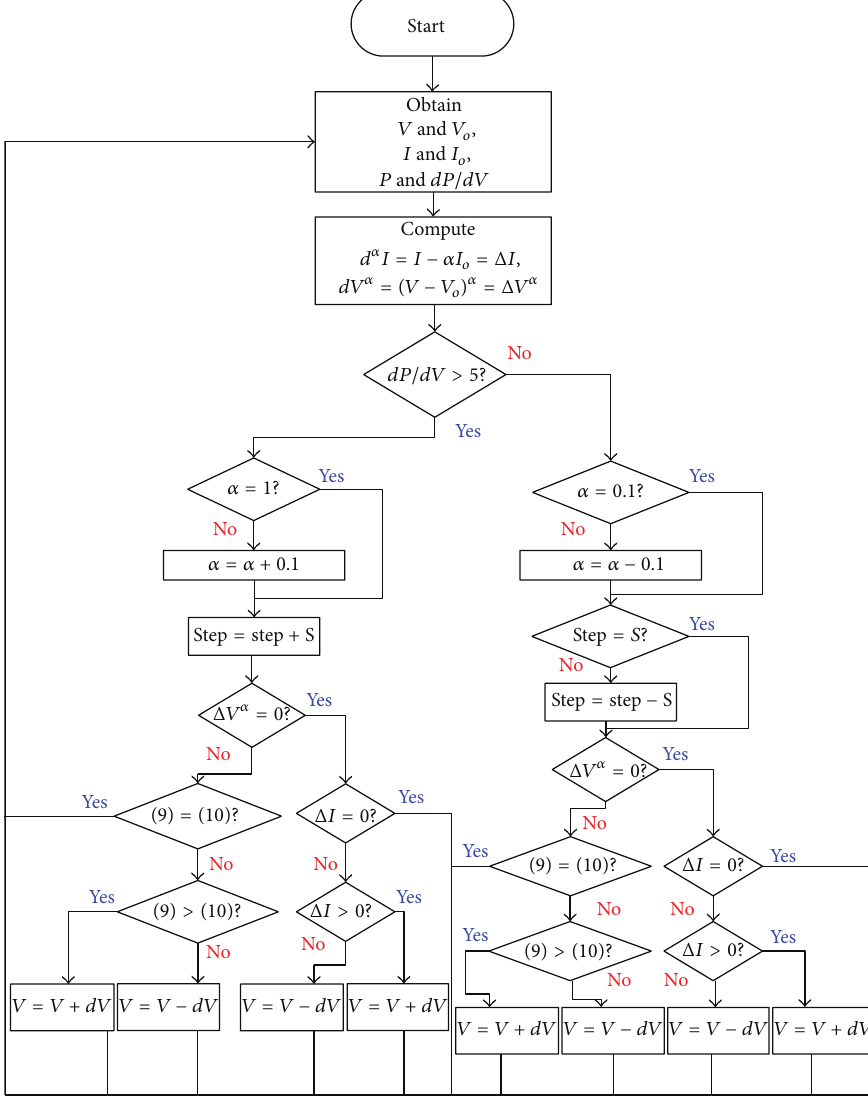
Figure 7: The control flow of VFOINC +